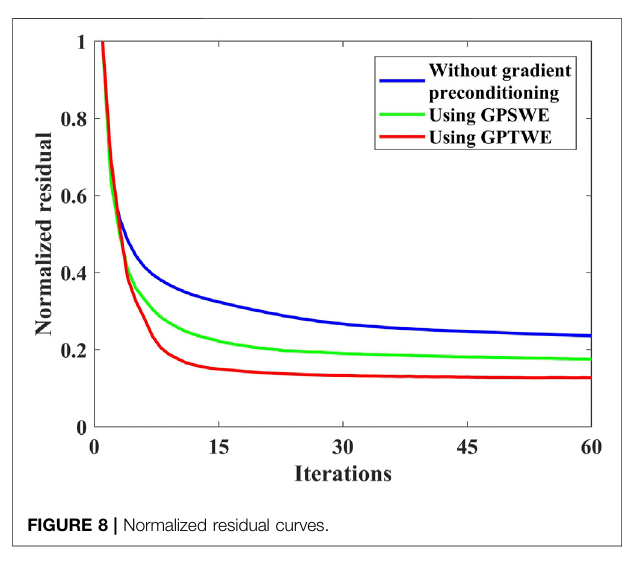
FIGURE 8 | Normalized residual curves.